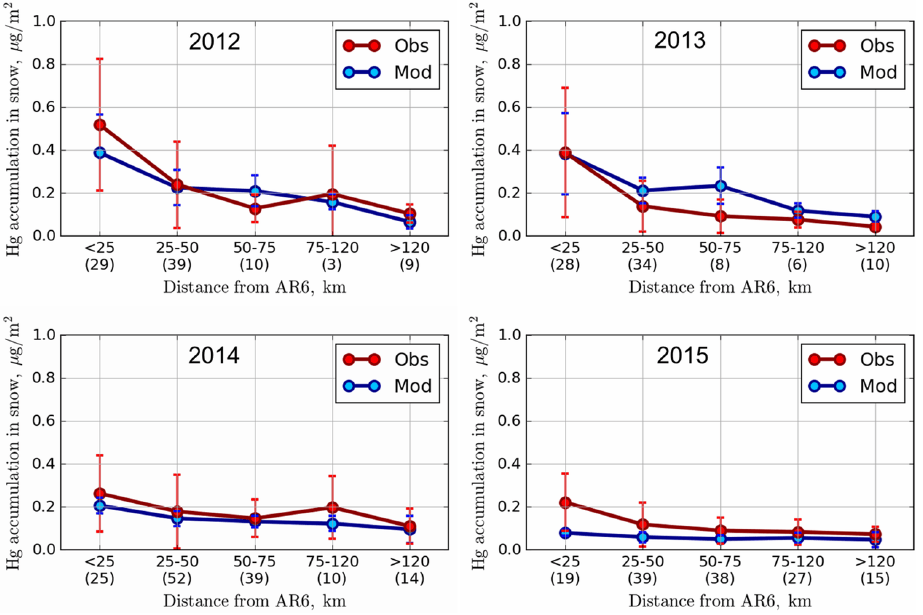
Figure 10. Average modelled (µgm − 2 ; blue) and observed (µgm − 2 ; red) end-of-winter Hg loadings in snowpack within 25, 25–50, 50–75, and 75–120 and > 120km distances from AR6 along with ± 1 standard deviation. Modelled accumulated Hg in the snow was sampled at the observation sites. Numbers in parentheses provide the number of observation sampling sites in each distance